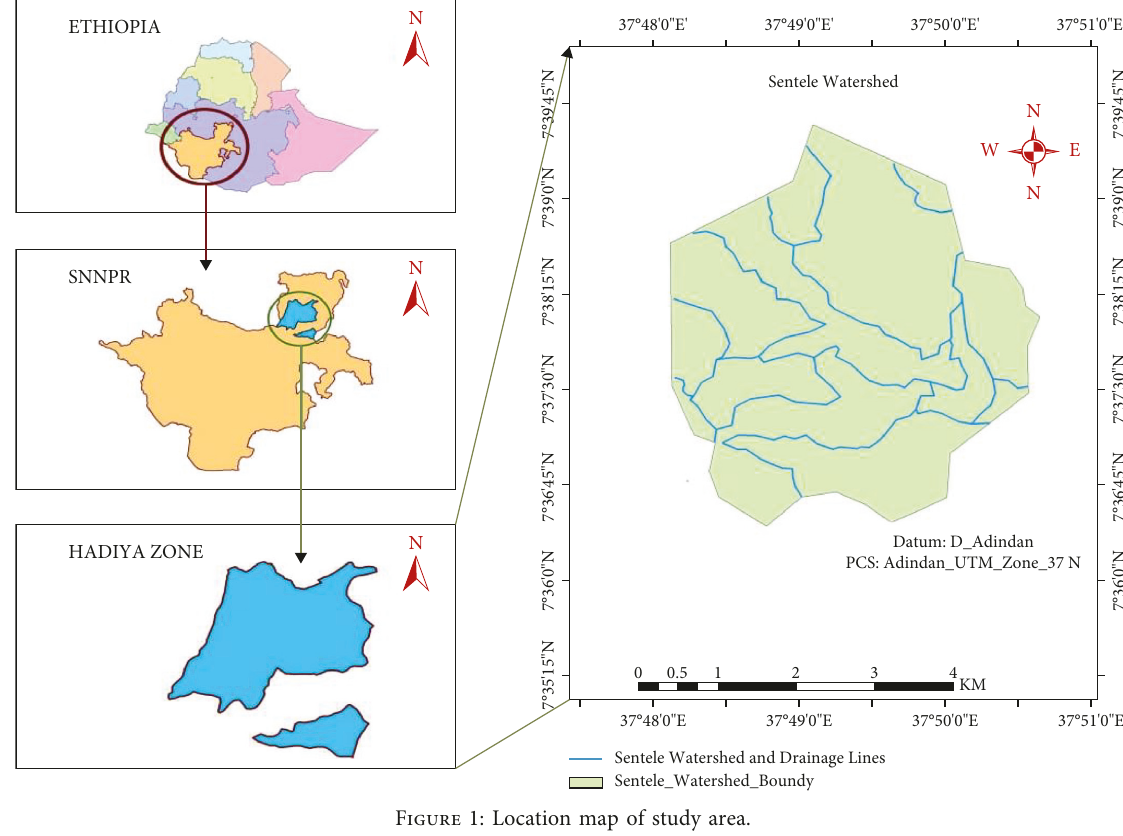
Figure 1: Location map of study area.